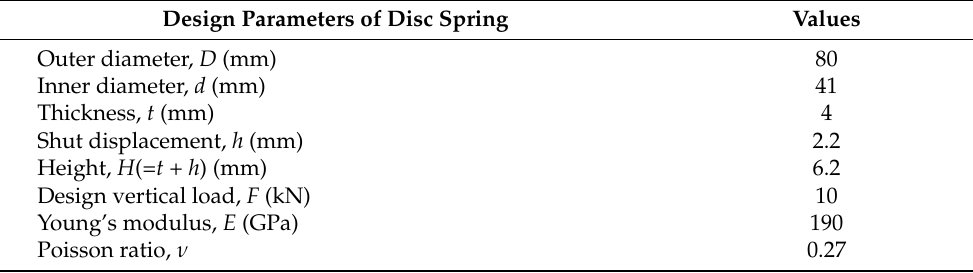
Table 5. Design parameter values for a single disc spring.